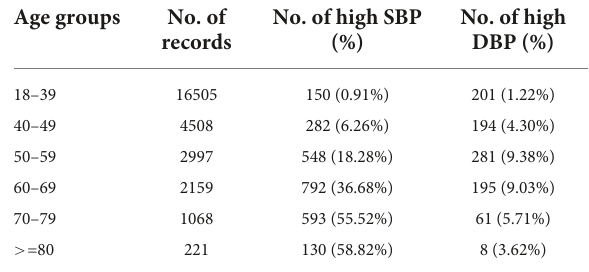
TABLE 3 Prevalence of high SBP/DBP in different age groups among